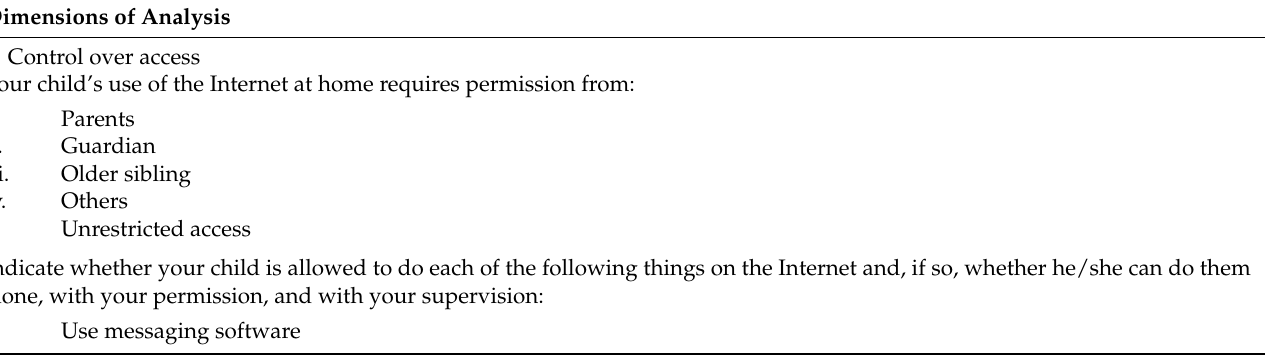
Table 1. Aspects evaluated in relation to parenting mediation